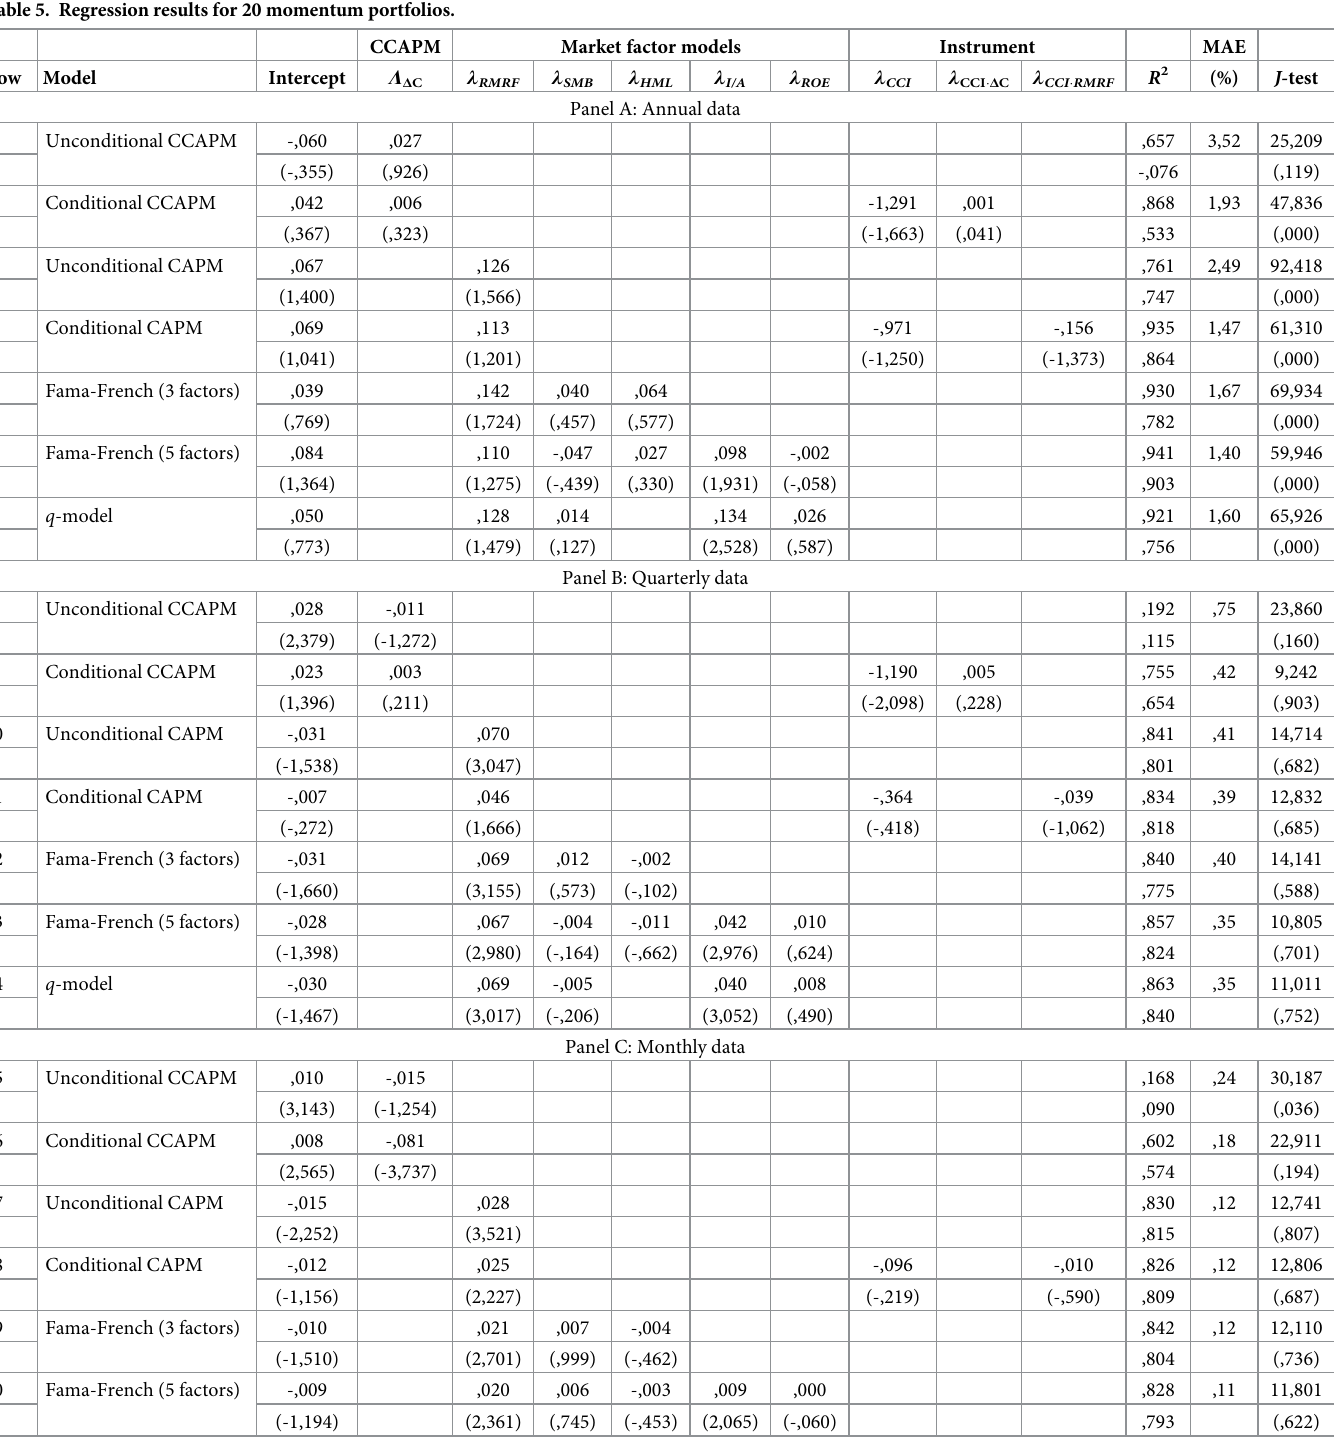
Table 5. Regression results for 20 momentum